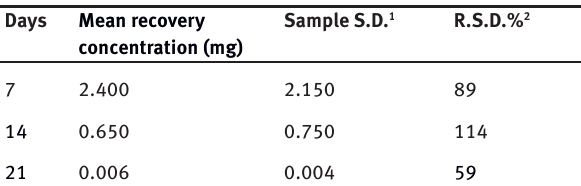
Table 5: Mean recovery concentration and standard deviation of residuals.